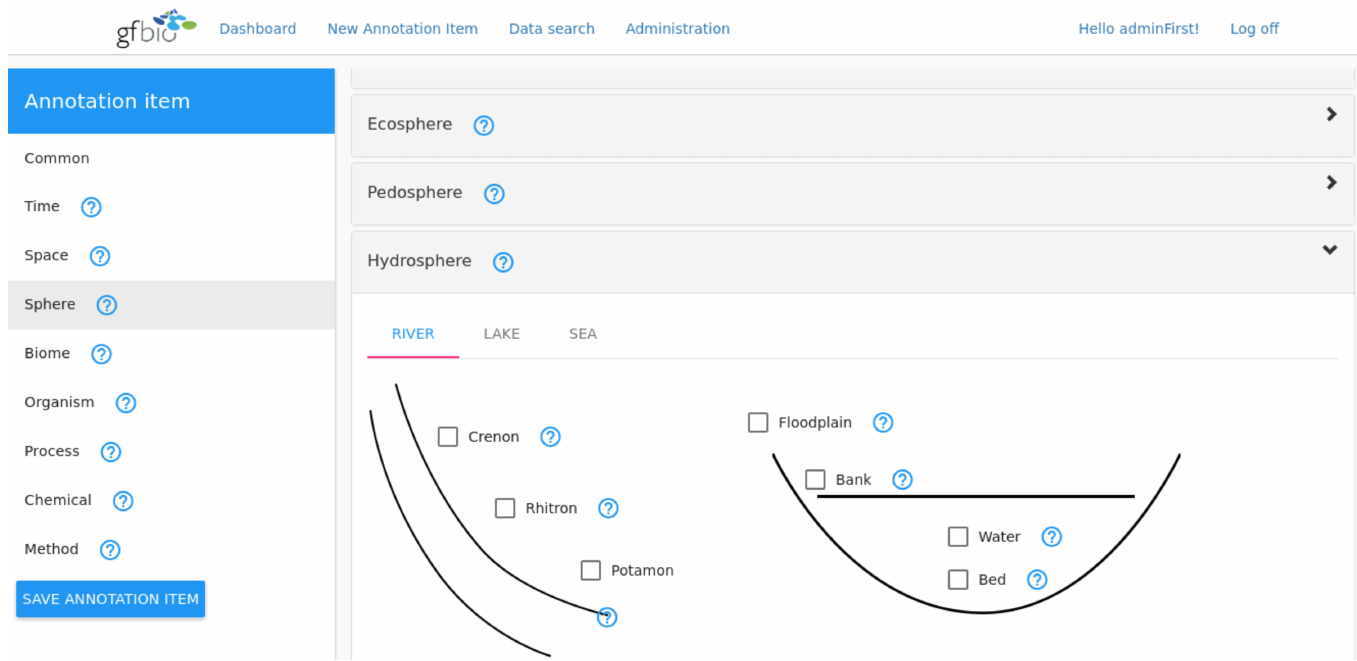
Fig 1. A mockup of a potential annotation tool which will be developed in the future based on the principles of the EASE framework. The figure here specificallydepicts the sphere part, detailingthe sub-facet hydrosphere. To allowfor a finer granularitywithin the hydrosphere, the tool will allowto specify specific zones in and related to rivers, lakes or the sea. Within these sub-facets, one can easily state where measurements or samples have beentaken. To guide the user and allow for a qualitative annotation,definitions of the respective concepts should be displayede.g. by resting with the cursor over the questionmarks. In case the user does not find suitableconcepts in a specific category he will be provided with an optionto extend the annotationvocabulary on the fly (i.e. not shown